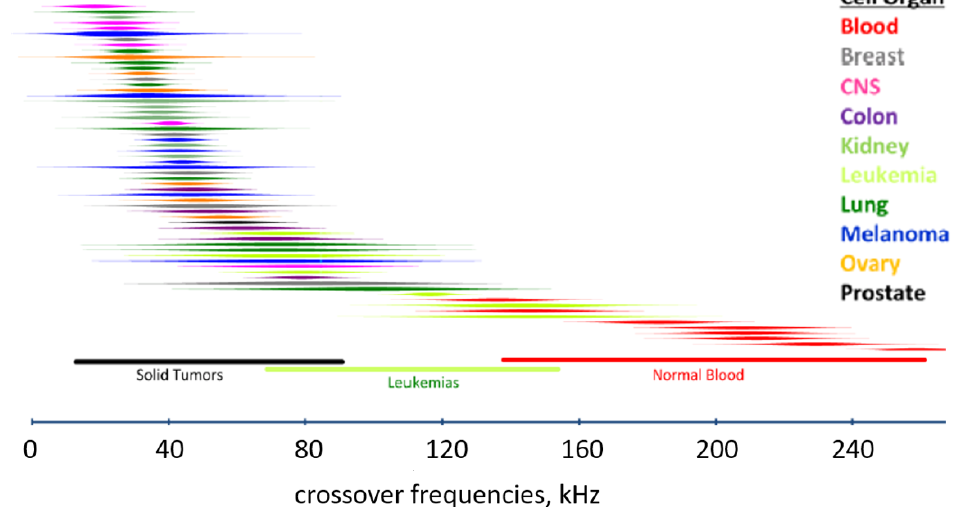
Figure 3. The DEP responses of cancer and normal blood cells expressed in terms of first crossover frequency 𝑓 𝐶𝑂1 (Adapted from ref [24]).